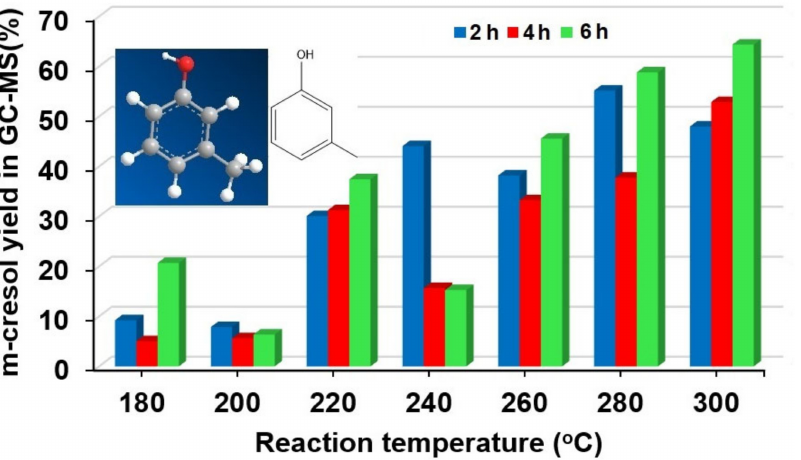
Figure 10. The effect of the reaction temperature on the m-cresol yield at various reaction times using 5 wt.% commercial NiAl catalyst with respect to biomass quantity at reaction conditions of 2 bars initial N 2 pressure, 2 g biomass, methanol solvent, and 180 µ m biomass particle